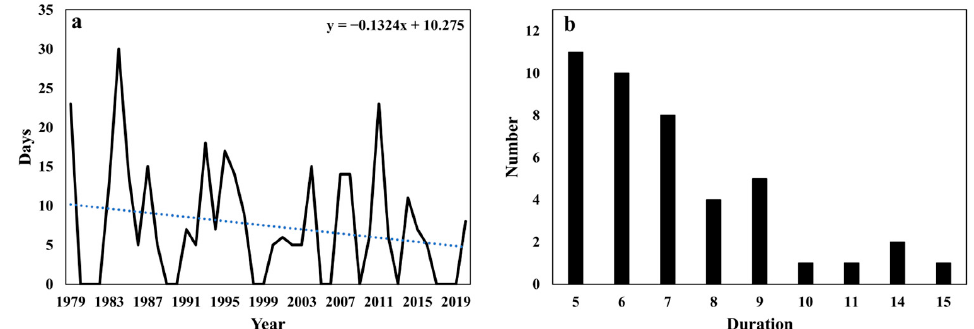
Figure 2. ( a ) The cumulative days of blocking high varied annually (unit: day), and ( b ) the number of times of blocking high in different lifetime (unit: times) in the Ural Mountains region.